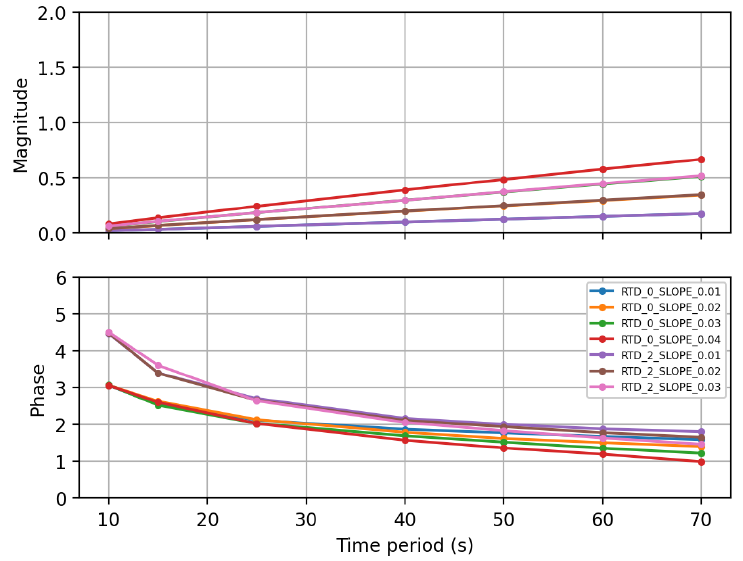
Figure 13. Multiple Bode plots depicting the impact of injected latency and slope of the ramp controller to FCR frequency response (phase in